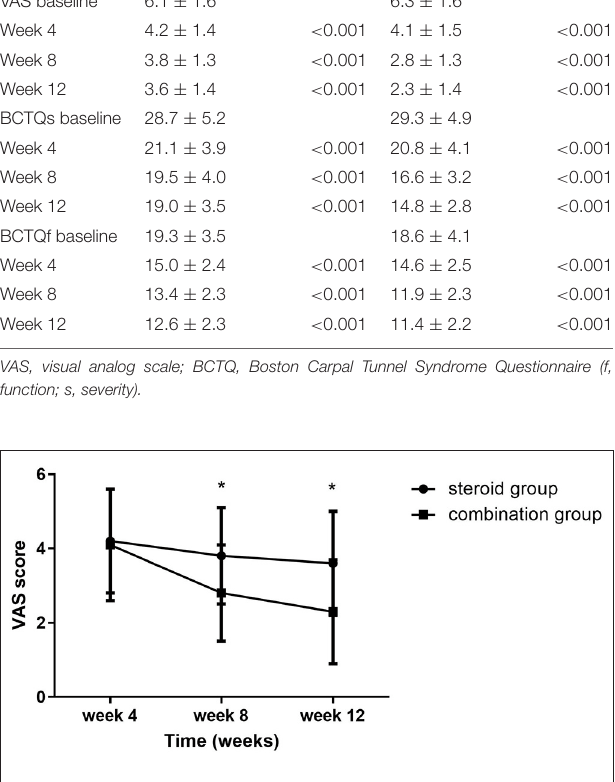
FIGURE 2 | VAS at 4-, 8-, and 12-week follow-up between the steroid and combination groups (mean ± SD). The differences were significant at weeks 8 and 12 (* P < 0.01, ANOVA with subsequent post-hoc Bonferroni test was used). VAS, visual analog scale.